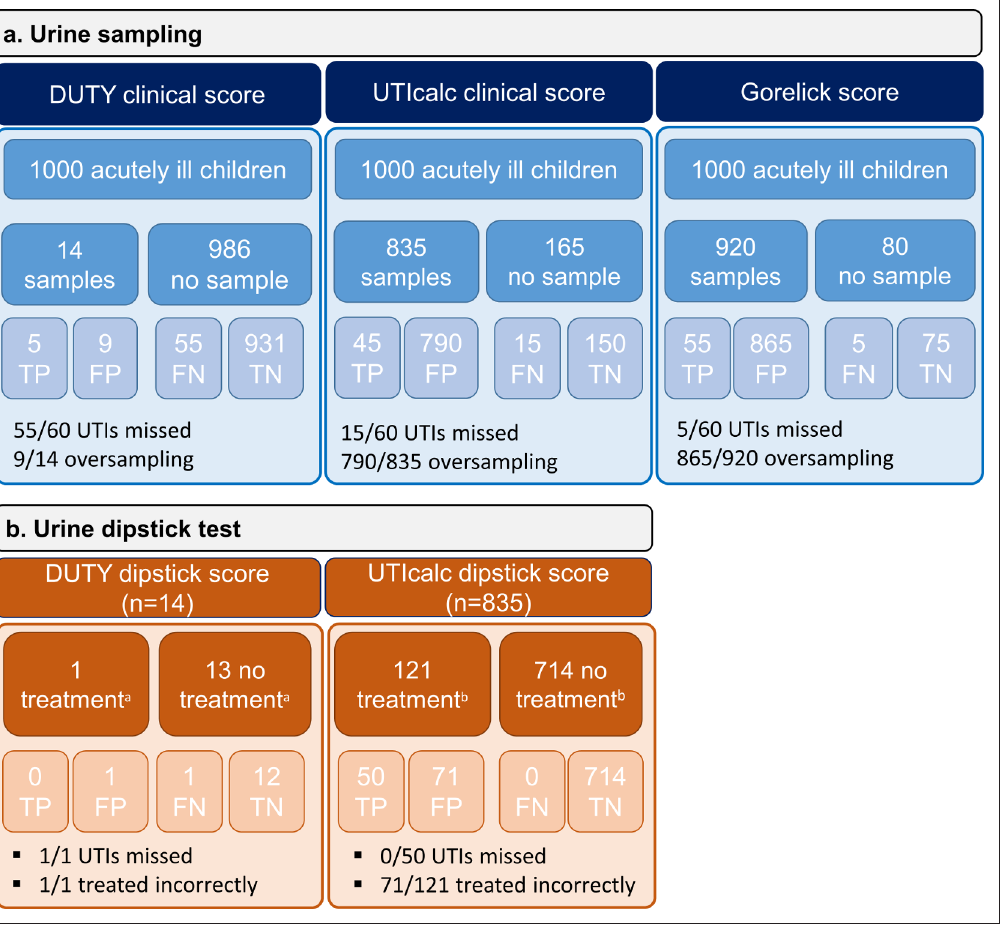
Figure 4 Simulation for 1000 acutely ill children based on sampling and treatment strategies. Simulation for 1000 acutely ill children based on ERNIE4 study results (assuming UTI prevalence of 6%). 22 a Positive DUTY dipstick model ≥6 points (for example, clinical model positive and ≥1 variable on the dipstick test positive). b Positive UTICalc dipstick model (probability of UTI ≥5% in children with positive clinical model). DUTY = Diagnosis of Urinary Tract Infections in Children. FN = false negatives. FP = false positives. TN = true negatives. TP = true positives. UTICalc = UTI Calculator. UTI = urinary tract